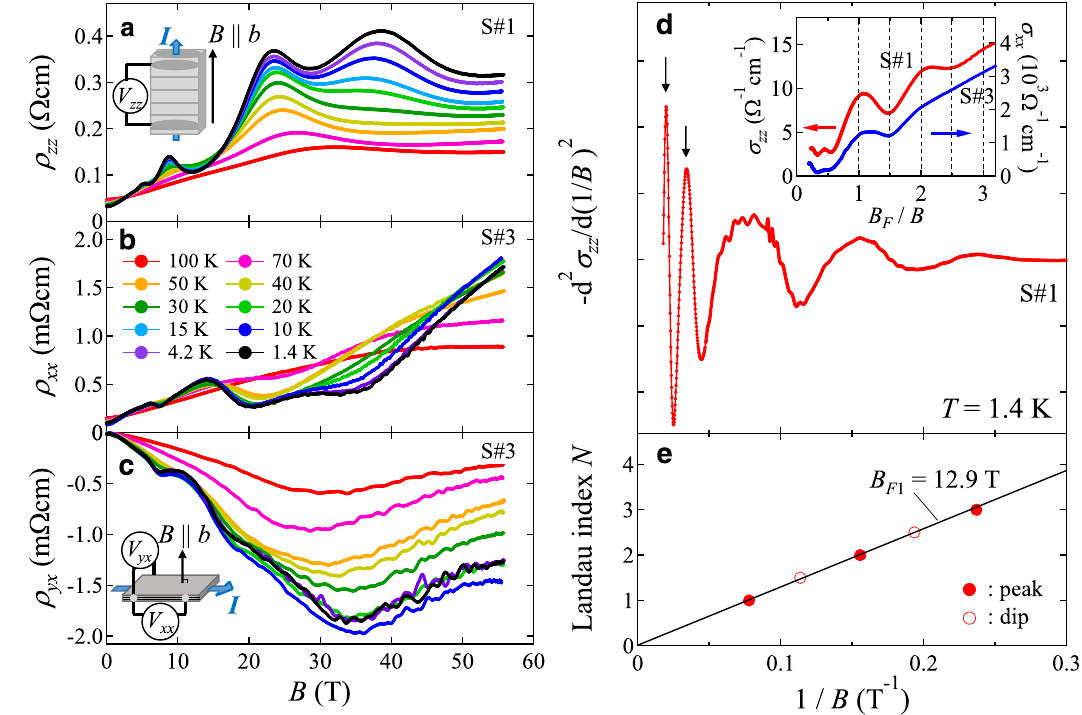
Fig. 3 Magnetoresistivity at high fi elds and analysis of the quantum oscillations. a , b , c , Field ( B ) dependence of ρ zz ( a ), ρ xx ( b ), and the in-plane Hall resistivity ρ yx ( c ) of BaMnBi 2 . The insets in a and c illustrate the con fi gurations for the interlayer and in-plane measurements. d − d 2 σ zz / d (1/ B ) 2 at T = 1.4 K plotted as a function of 1/ B . The inset shows σ zz (red) and σ xx (blue) as a function of the normalized fi lling factor B F / B . e The Landau fan diagram obtained from − d 2 σ zz / d (1/ B ) 2 . The black solid line is the linear fi t to the experimental data.